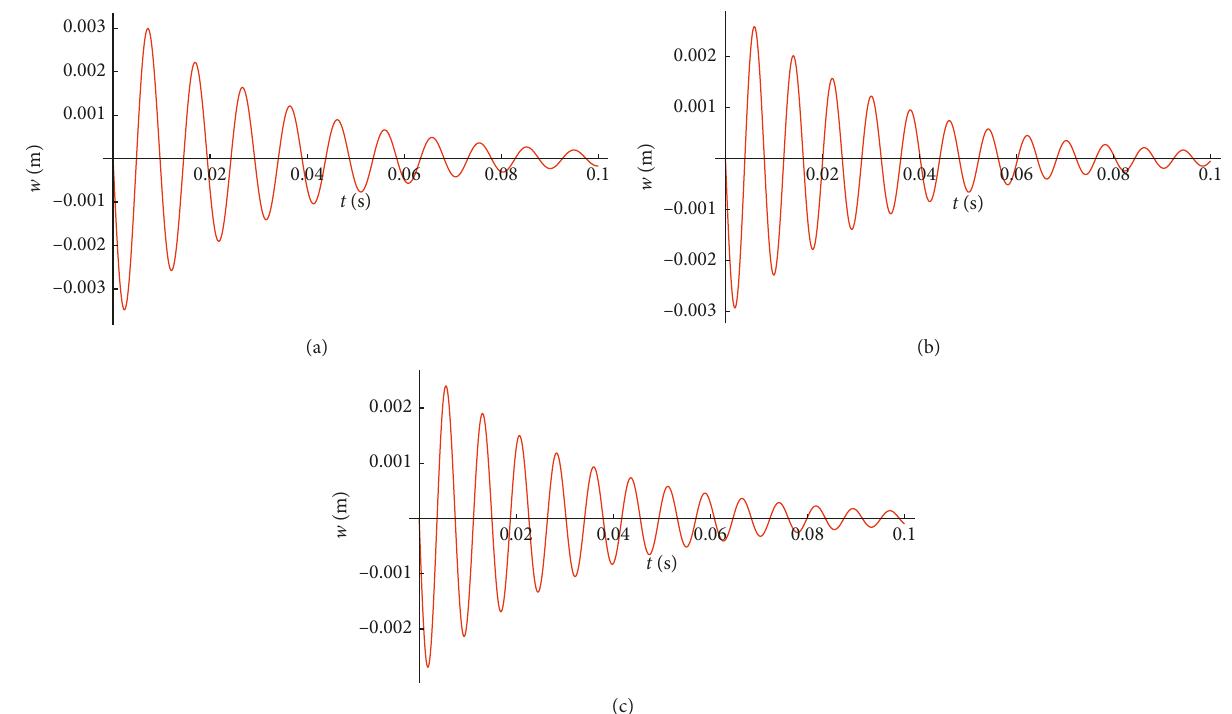
Figure 3: Time history curves of the first three orders of saddle membrane structure: (a) 1st order; (b) 2nd order; (c) 3rd